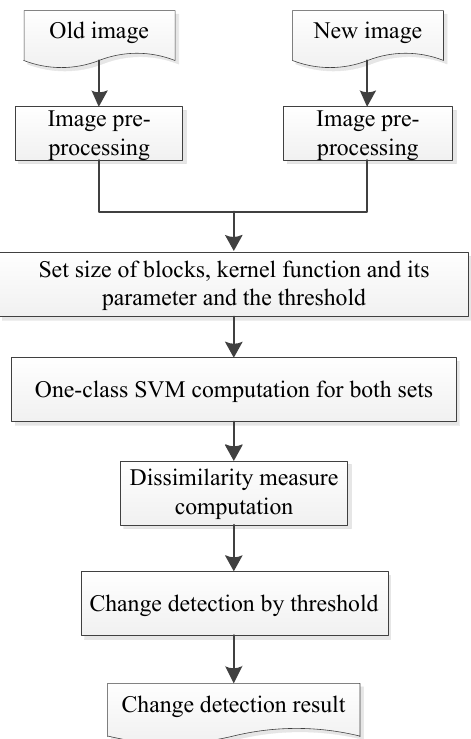
Figure 3 Overall functional diagram of the